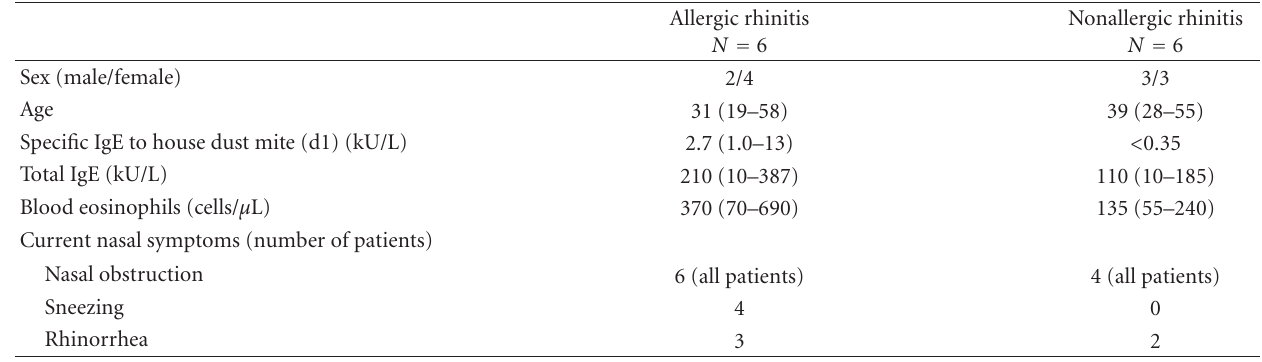
Table 1: Demographic characteristics of allergic and nonallergic